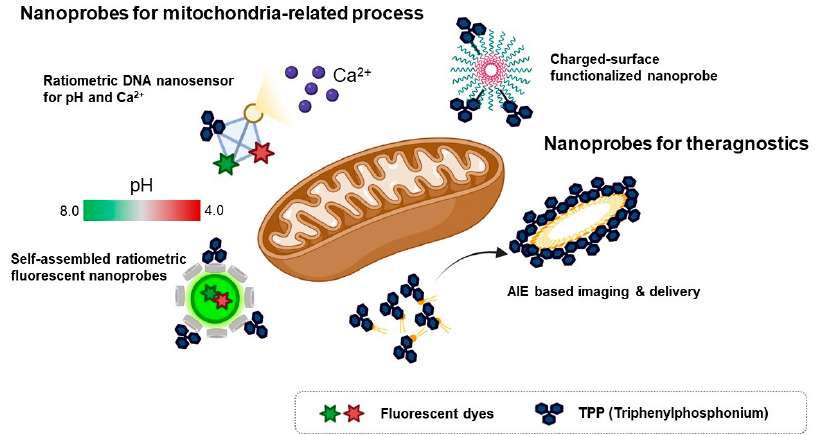
Figure 4. Schematic diagram for various types of mitochondria-targeting fluorescent nanoprobes [60–63]. Figure was depicted from the concept of individual fluorescent material in references [60–63].